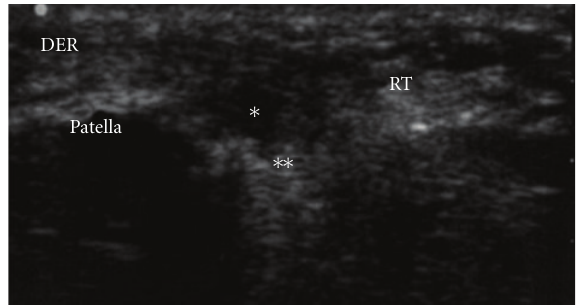
Figure 3: Under US guide, the cells were inoculated. Observe the hypoechoic area ( ∗ ) where the cells were inoculated. An acustic shadow is evident after the inoculation of the cells ( ∗∗ ). RT: rotulian or patellar tendon.